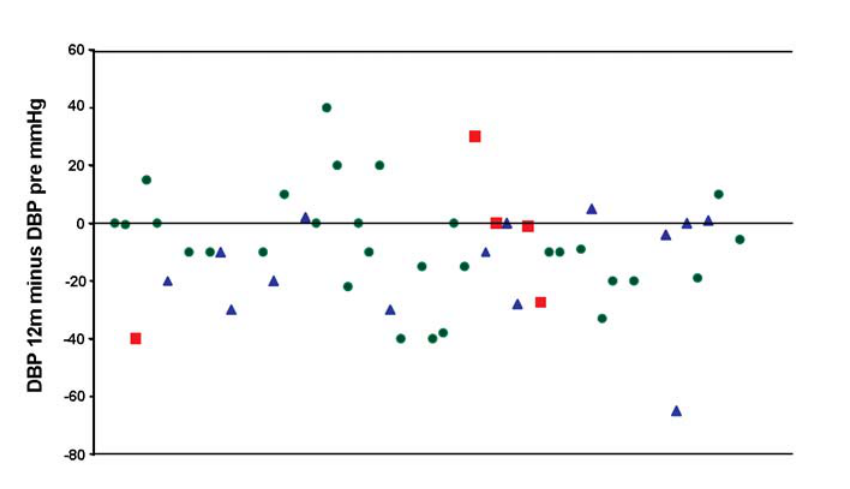
Figure 3 – Variation of the DBP of each patient 12 months after nephrectomy (n = 49). (cid:404)(cid:3) reduction, (cid:376) same and (cid:374)(cid:3) increase in the number of